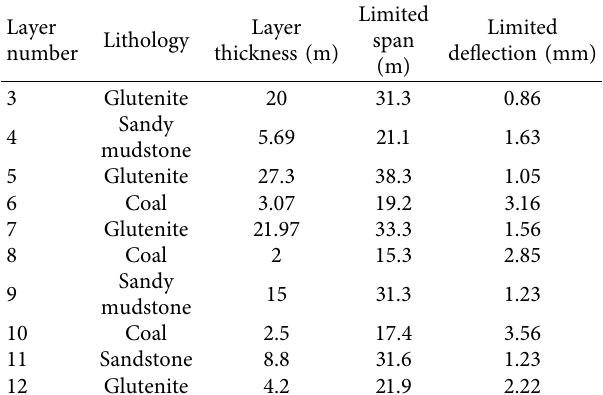
Table 3: The limited span and deflection of overlying